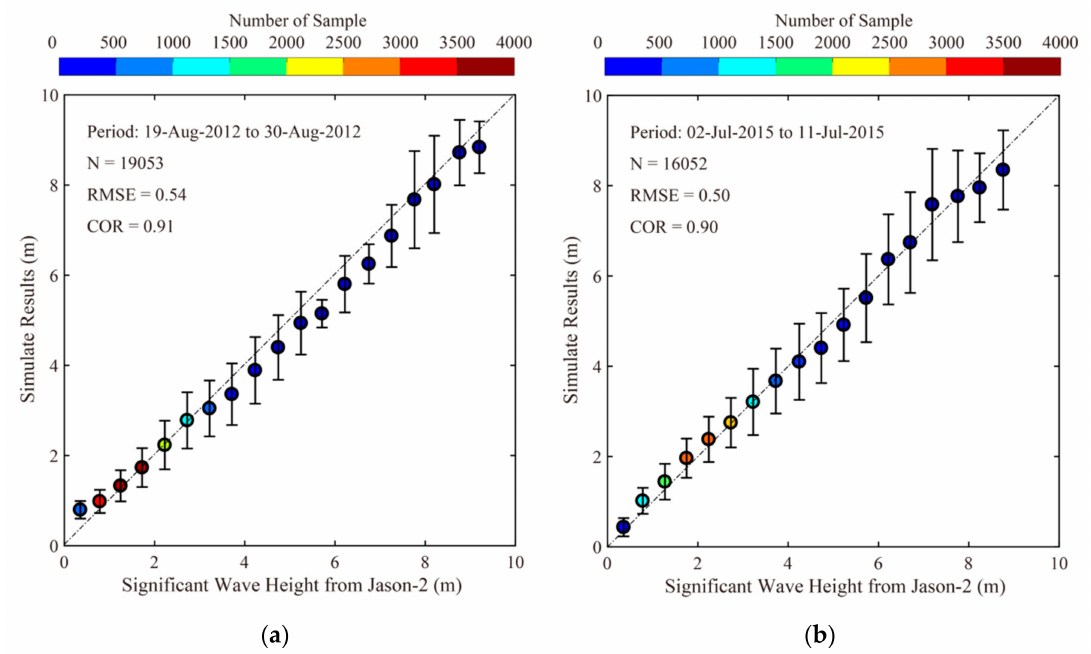
Figure 6. Comparisons of WW3-simulated SWHs with measurements from the Jason-2 altimeter in 0.5-m bins between 0 and 10 m. ( a ) 19–30 August 2012; ( b ) 2–11 July 2015.